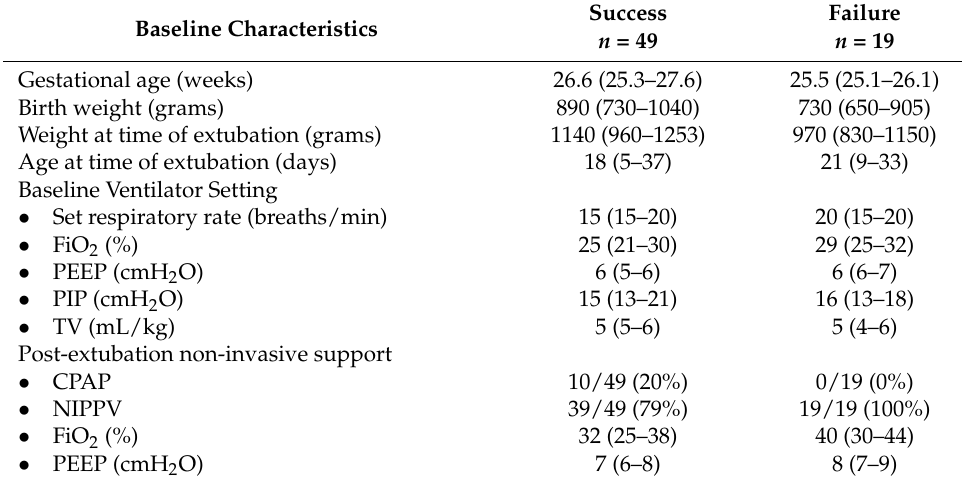
Table 1. Demographics and respiratory characteristics.